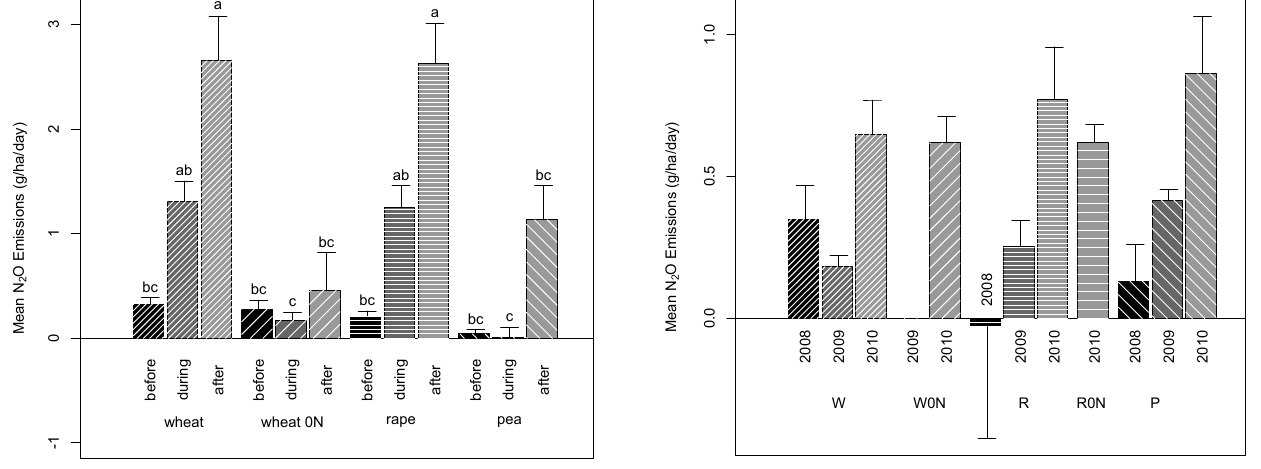
Fig. 3. Mean N 2 O emissions (gN-N 2 Oha − 1 day − 1 ) as a function of the crop (wheat, winter rape or pea), fertilized or not (0N) and period of observation (before the first N fertilisation, more than 14 days after the last N fertiliser or during the period of N fertilization). Bars with the same letter are not significantly different. Error bars=standard error of the mean.